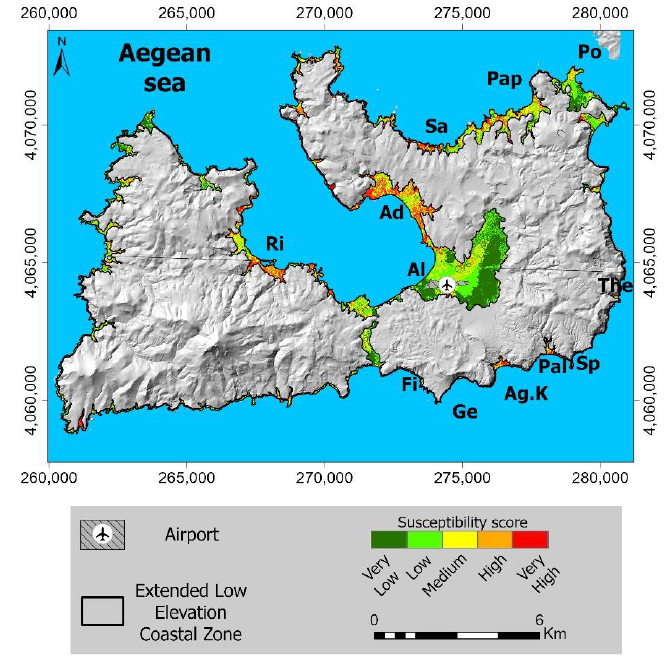
Figure 12. AHP ranking of Milos island’s extended low elevation coastal zone multi-hazard susceptibility map.